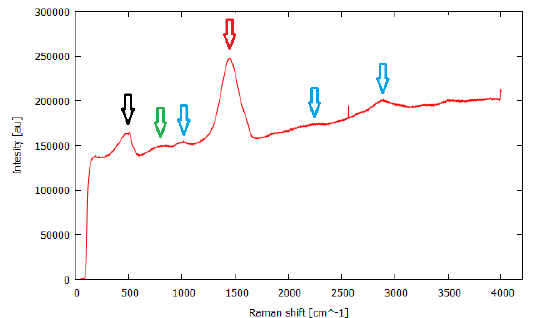
Figure 3. Raman spectrum of K2